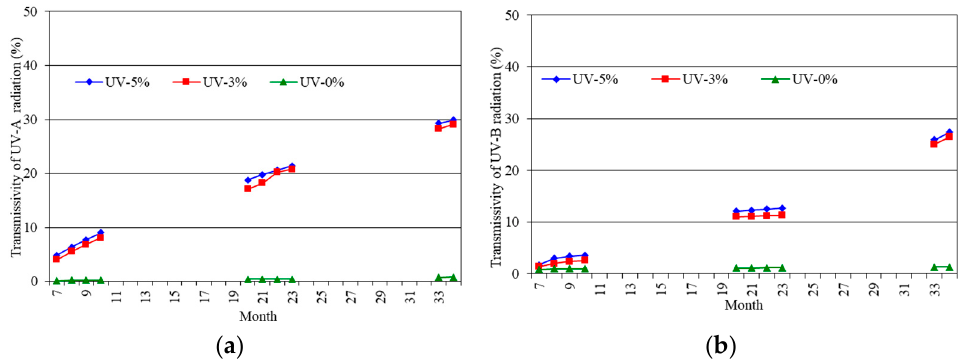
Figure 3. Monthly changes in covering material transmissivity for: ( a ) UV-A; and ( b ) UV-B radiation. The first measurement was taken seven months after the installation of the films.